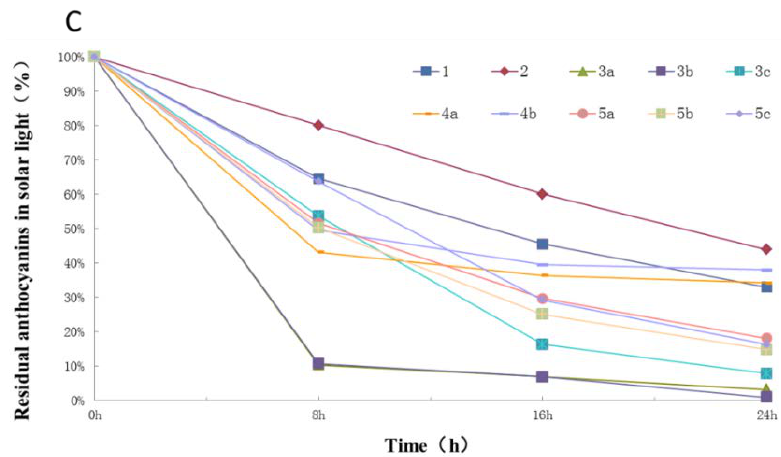
Figure 6. Stability of anthocyanins in darkness ( A ), exposed to room light ( B ) and simulated solar light ( C ).